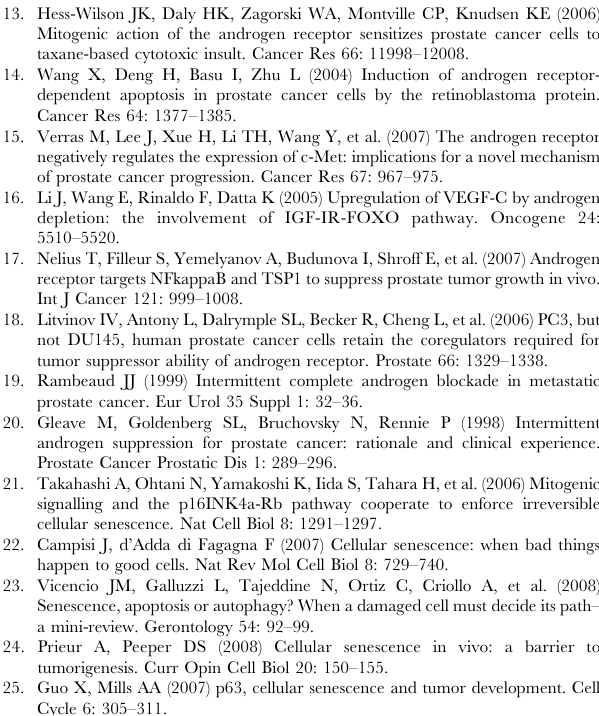
Figure S4 Senescence-associated proteins in DHT-treat-